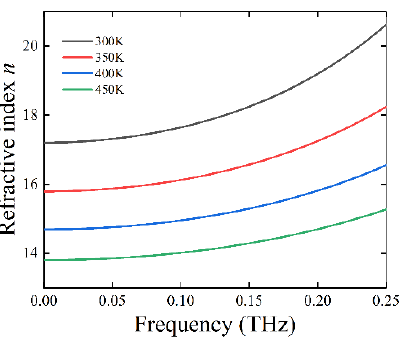
Figure 2. The relative refractive index, n, of strontium titanate.